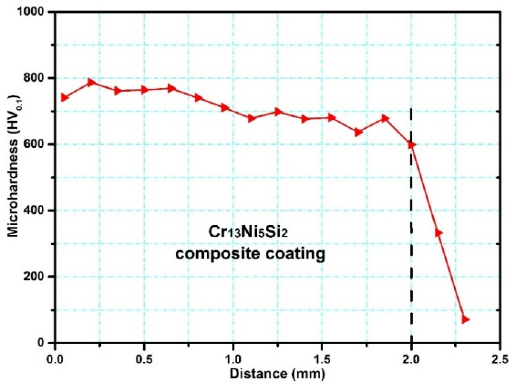
Figure 12. Vickers microhardness curve along the depth direction.